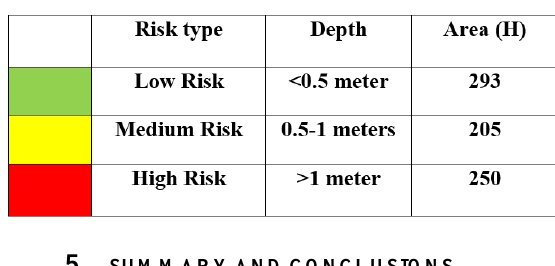
Table 6: Classification of inundation